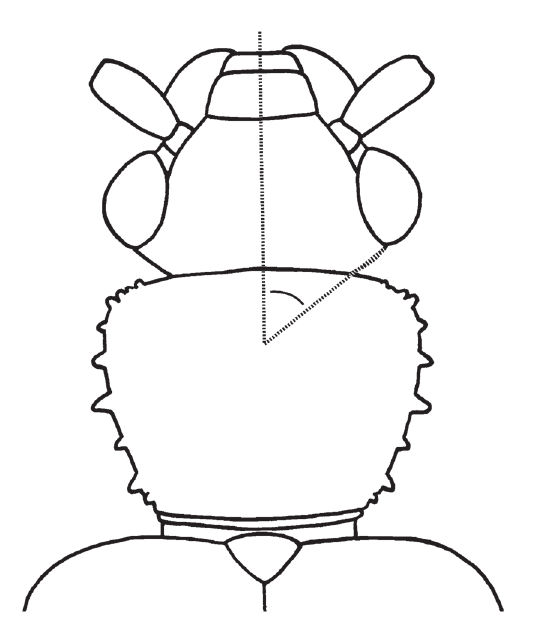
Fig. 1. Scheme for temple angle